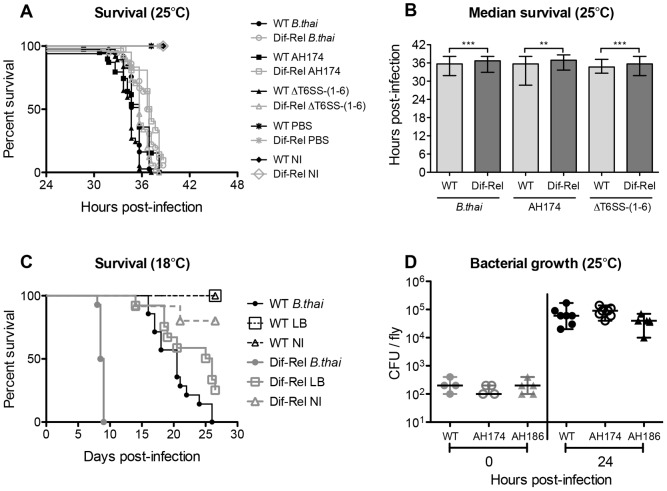
Type III (T3SS) and VI (T6SS) secretion systems are not required for virulence in Drosophila.(A) Survival of wild-type or Dif; Rel mutant flies infected with exponential-phase wild-type, T3SS-mutant (AH174) or T6SS-mutant B. thailandensis, maintained at 25°C, and counted at least every hour. (B) Median survival times from [A]. Statistical significance was determined using Mann-Whitney test; ** p<0.002 and *** p<0.0005. (C) Survival of wild-type and Dif; Rel mutant flies after infection with wild-type B. thailandensis E264 at 18°C. Under these conditions, Dif; Rel mutants were significantly shorter-lived. Statistical significance between the survival curves of infected WT and mutant flies was determined using Log-rank analysis (Mantel-Cox); p<0.0001. The data showing the WT Drosophila subset is the same as in [Fig. 2A]; all results shown here were obtained at the same time. (D) Proliferation of the T3SS mutant (AH174), and complemented AH186 mutant in WT Drosophila. Statistical significance of bacterial growth between time points was determined using Mann-Whitney test.